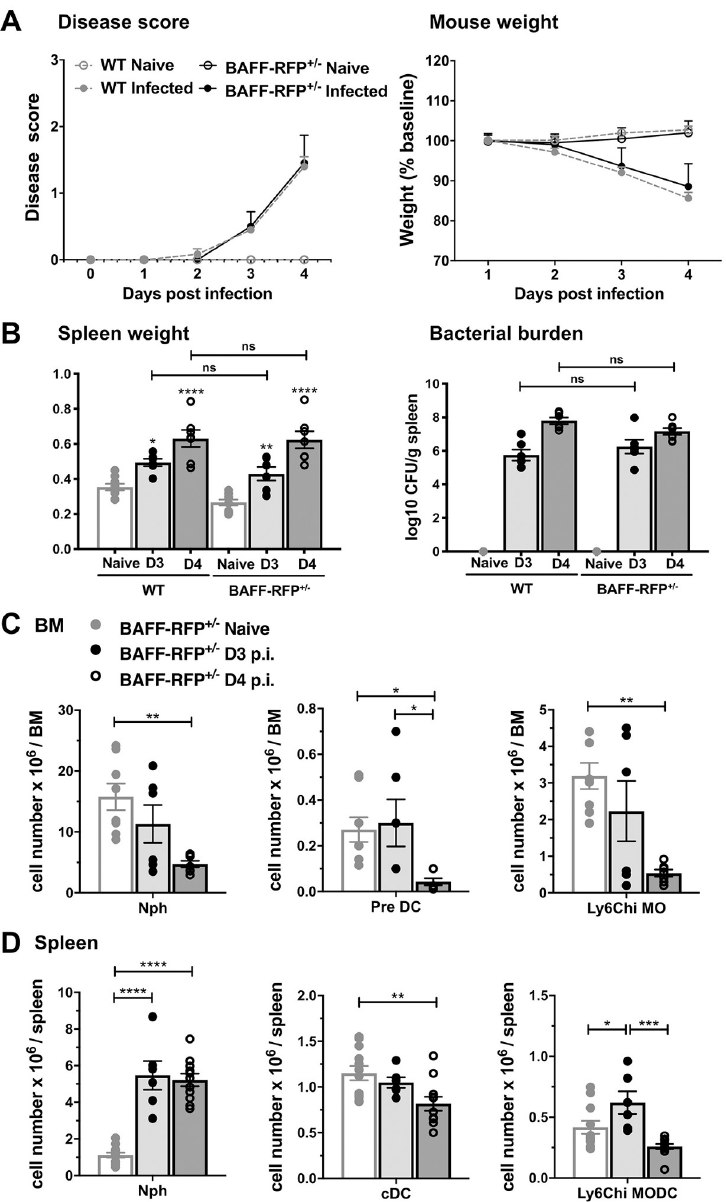
Fig 1. Clinical outcome and early myeloid cellular responses in BAFF-RFP +/- mice after S . typhimurium infection. WT mice and BAFF-RFP +/- mice were infected i.p. with 500 CFU S . typhimurium . (A) Clinical scores and mouse weights were taken daily. (B) Spleen weights and splenic bacterial burdens were measured at day 3 and 4 p.i. Data are combined from three independent experiments (n = 6–10). (C and D) Cells from BMs and spleens were harvested at day 3 and 4 p.i., and myeloid cell subsets were determined by flow cytometry. (C) Numbers of BM Nphs (CD11b + Ly6G hi Ly6C int SSC int- ), Pre DCs (CD11b + CD11c + Ly6C - CD115 + CX3CR1 hi CCR2 + MHCII + Ly6G - SSC - ) and Ly6C hi MOs (CD11b + CD11c - CD115 + CX3CR1 + CCR2 hi MHCII - Ly6G - SSC - ) from BAFF-RFP +/- mice after S . typhimurium infection. Graphs summarize data from three independent experiments (n = 6–8). (D) Numbers of splenic Nphs (CD11b hi Ly6G hi Ly6C int SSC int- NK1.1 - ), cDCs (CD11c hi CD8 +/- B220 - Ly6G - NK1.1 - ) and Ly6C hi MO/DCs (CD11b hi Ly6C hi CD11c hi/- SSC - Ly6G - NK1.1 - ) from BAFF-RFP +/- mice after S . typhimurium infection. Data are combined from four independent experiments (n = 6–12). (A) Timeline data of clinical scores and mouse weights were analyzed by Two-Way ANOVA with Holm-Sidak’s multiple comparison test. (B-D) Bar graphs show means ± SEM; � p < 0.05, �� p < 0.01, ��� p < 0.001, ���� p < 0.0001, as determined by One-Way Anova with Holm-Sidak multiple comparisons test.